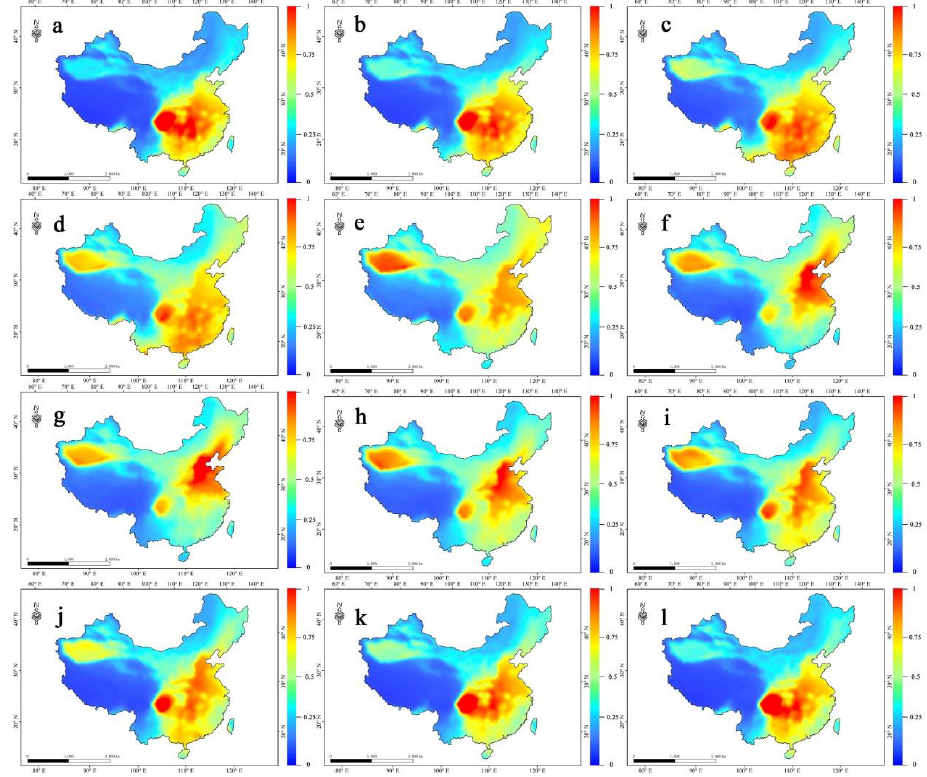
Figure.16. The monthly mean AOD values throughout China (a for January, b for February, c for 489 Figure 16. Distribution of the monthly mean AOD values throughout China during 1980–2015: March, d for April, e for May, f for June, g for July, h for August, i for September, j for October, k for 490 ( a ) January; ( b ) February; ( c ) March; ( d ) April; ( e ) May; ( f ) June; ( g ) July; ( h ) August; ( i ) September; ( j ) October; ( k ) November; and ( l ) December. November and l for December). 491 Daily meteorological measurements including surface pressure, surface temperature, relative 492 Daily meteorological measurements including surface pressure, surface humidity and sunshine duration at 716 CMA meteorological stations and retrieved AOD values 493 were used to reveal the spatial and temporal variations of SSR over mainland China. Figure.17 and 494 Figure.18 illustrated the spatial and temporal variations of SSR over mainland China. The result 495 showed that the monthly mean SSR values gradually increased from January to May and decreased 496 from June to December, owing to the variations of the annual cycle of solar zenith and the maximum 497 sunshine duration in China. The monthly mean SSR for January, February, March, April, May, June, 498 July, August, September, October, November, and December were 10.604, 13.349, 17.221, 21.420, 499